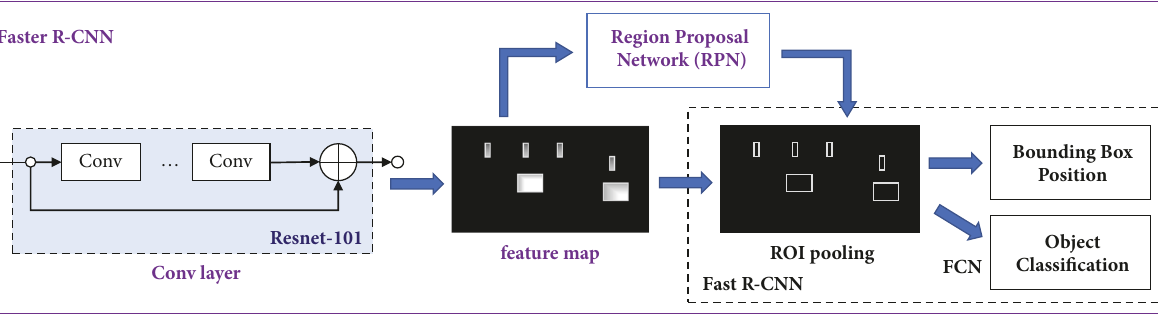
Figure 3: Block diagram of Faster R-CNN network model with